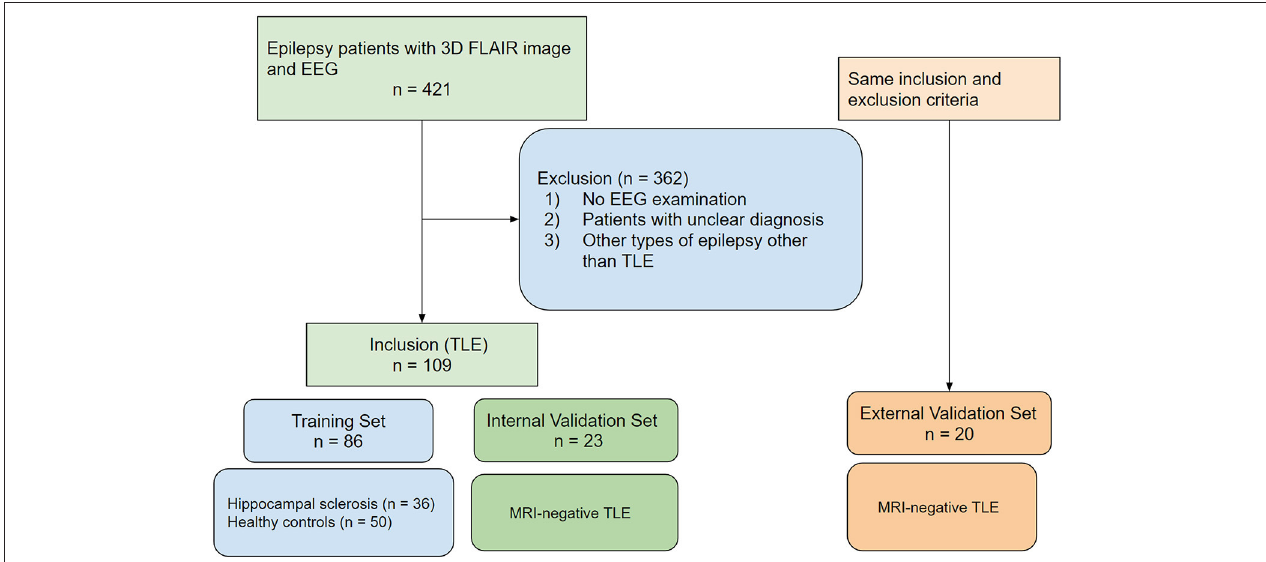
FIGURE 1 | Flow diagram of patient inclusion and allocation to training and validation